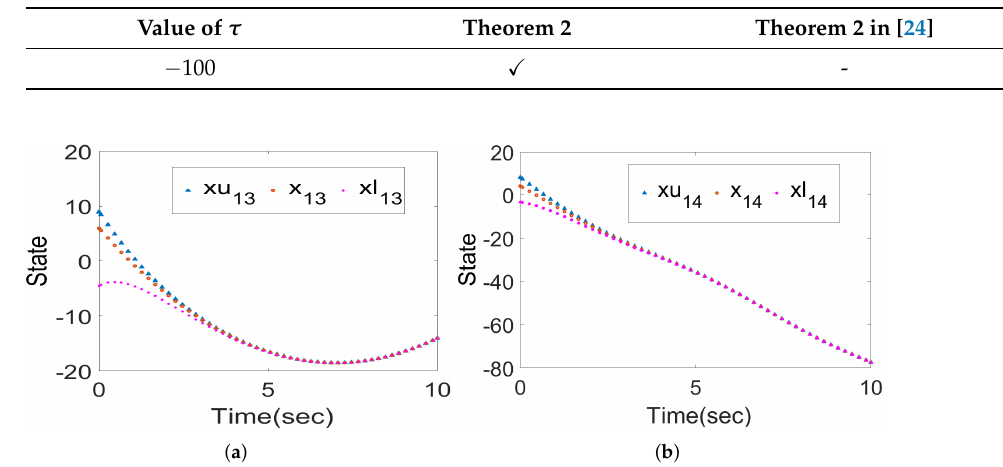
Table 3. The solution under different τ [24].